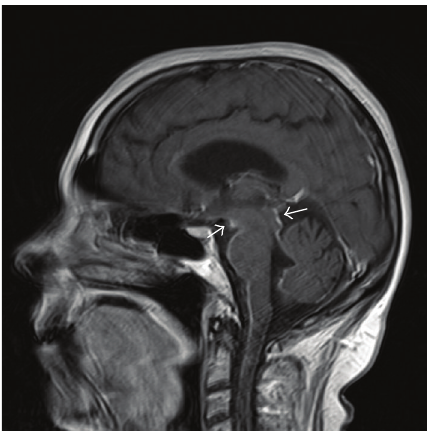
Figure 1: Sagittal T 1 postcontrast image of the brain: linear lep- tomeningeal enhancement along the ventral brainstem, the tectum, and the upper cervical spinal cord.